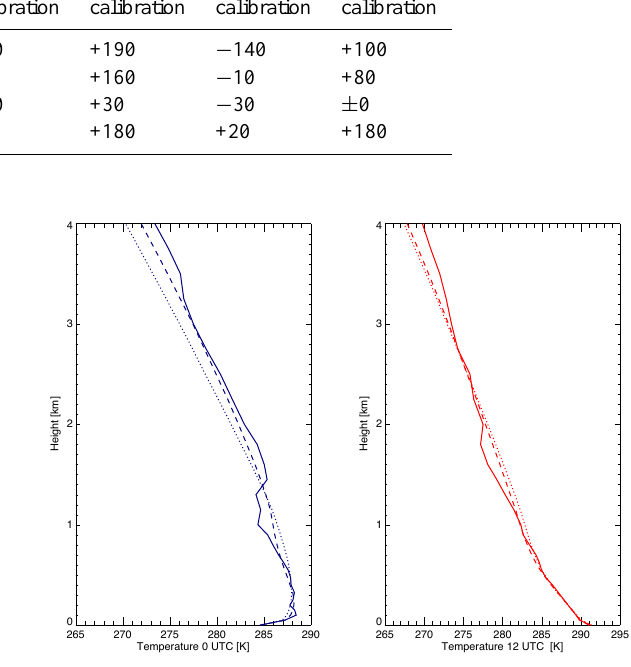
Fig. 6. Temperature profile at 00:00 (left) and 12:00 (right) UTC Figure 6 : Temperature profile at 0 (left) and 12 (right) UTC on 09 September 2008 between 0 and 4 650 on 9 September 2008 between 0 and 4km. The bold line shows the km. The bold line shows the radiosonde profile, the dotted line the MWR retrieval and the dashed line 651 radiosonde profile, the dotted line the MWR retrieval and the dashed the radiosonde profile smoothed with the averaging kernel. 652 line the radiosonde profile smoothed with the averaging kernel.